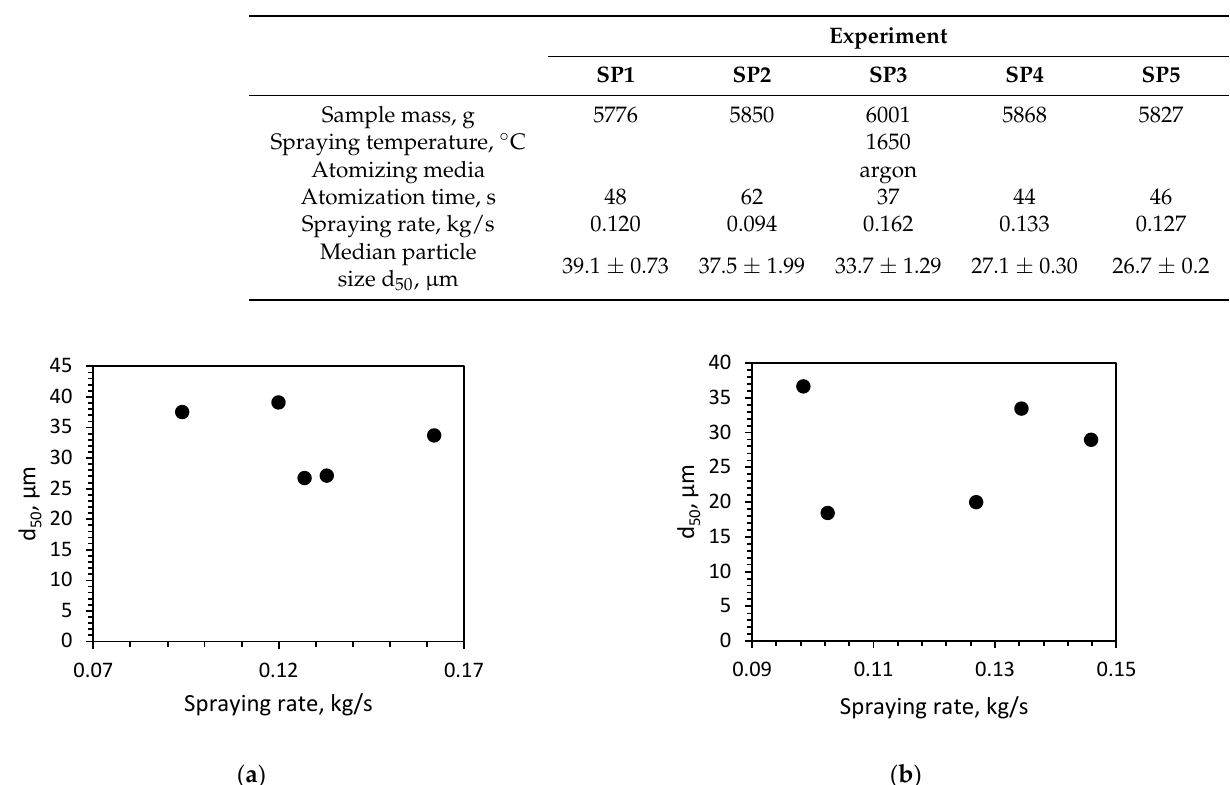
Table 2. Parameters of the atomizations and obtained powder.